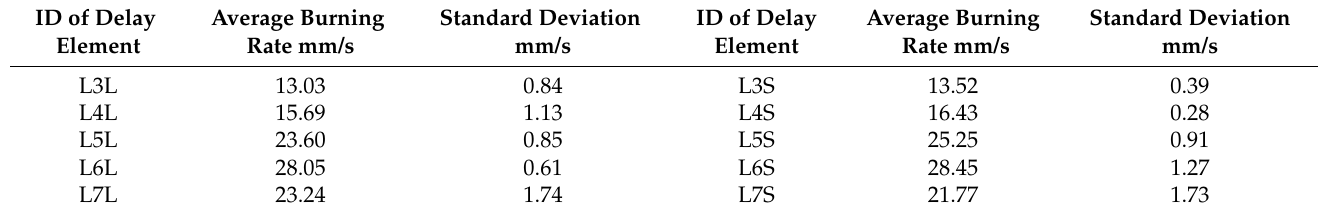
Table 4. Burning